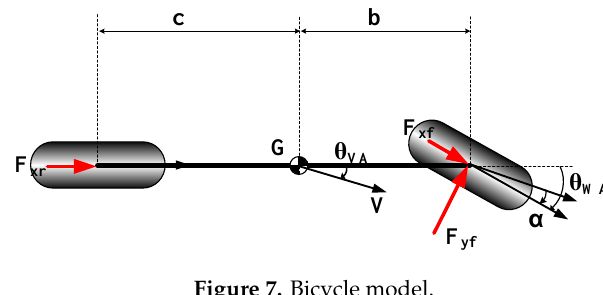
Figure 7. Bicycle model.